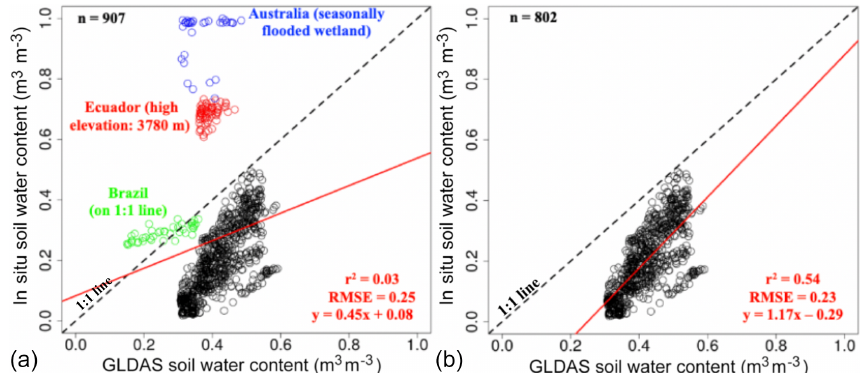
Figure 2. In situ soil moisture vs. GLDAS soil moisture during October to December (OND) and January to March (JFM) for El Niño years 1982–1983, 1997–1998 and 2015–2016. Each circle corresponds to one in situ data point in space and time. The left panel includes data from all 18 sites shown in Table 1, with data from Australia, Ecuador and Brazil highlighted in blue, red and green, respectively. The right panel shows the same information with the Ecuador, Australia and Brazil site data removed. The blue dashed line and red solid line represent the 1 : 1 line and the regression line, respectively.